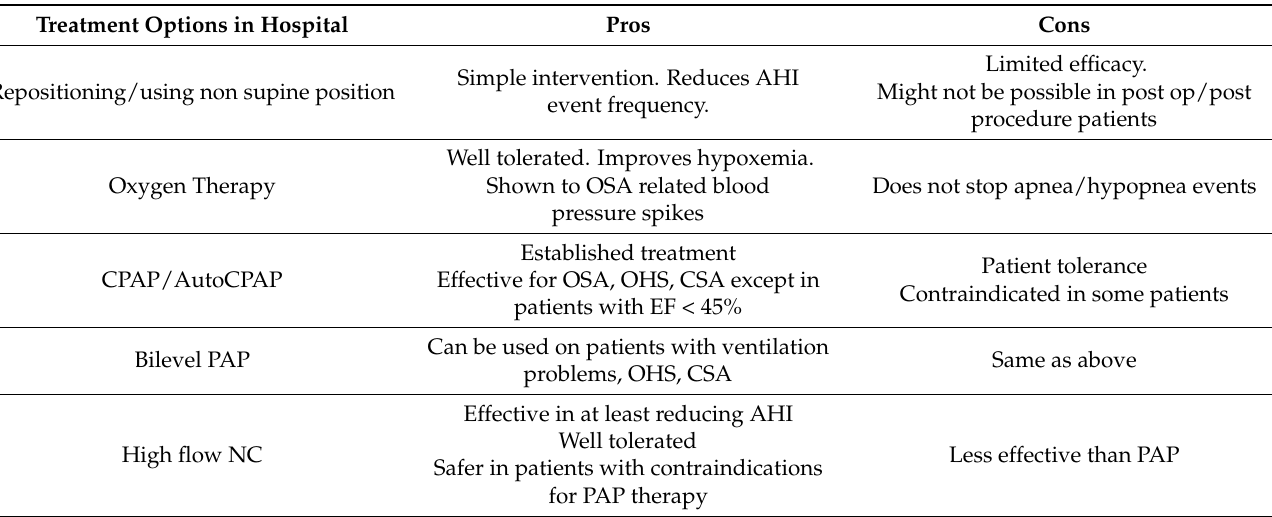
Figure 1. Algorithm for managing hospitalized patients with OSA. Table 3. Treatment therapies for OSA in hospitalized patients.